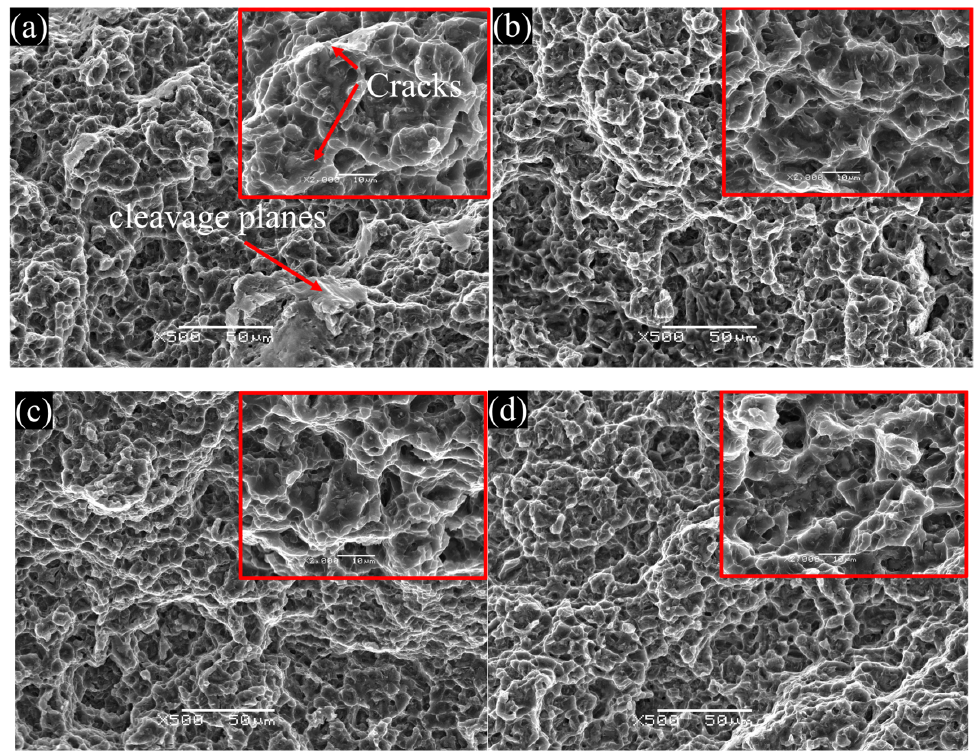
Figure 4. Tensile fracture morphologies of the as-extruded ( a , c ) and the as-aged ( b , d ) alloys at 25 °C ( a , b ) and 93 °C ( c , d ).